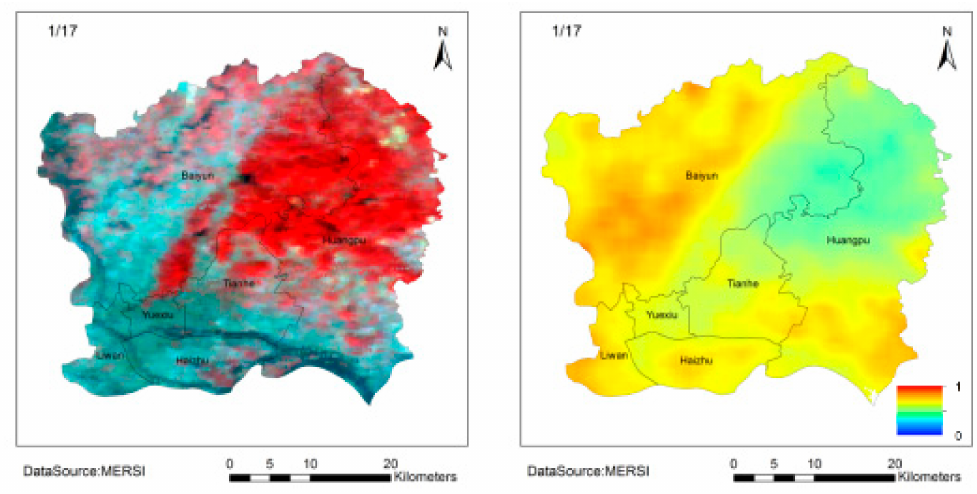
Figure 10. False-color (left) and AOD (right) images on 14–17 January 2015.